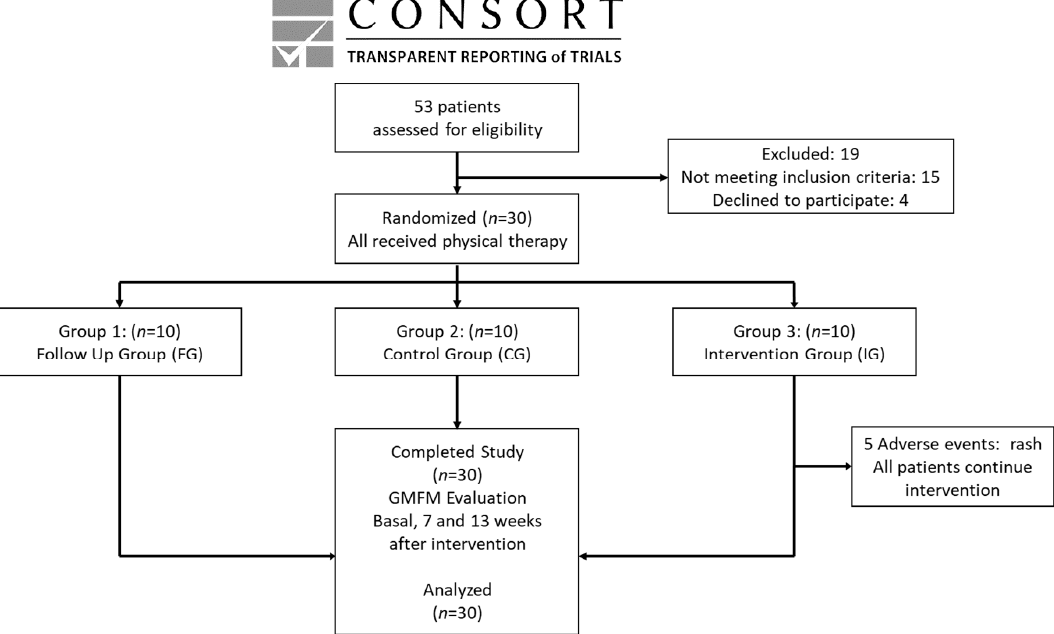
Figure 1. Consort, transparent reporting of trials.